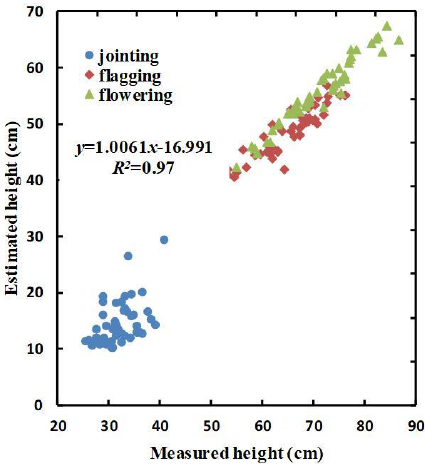
Figure 3. Measured and estimated heights of winter wheat. The three colors represent different growth stages: blue: jointing stage; red: flagging stage; green: flowering stage.